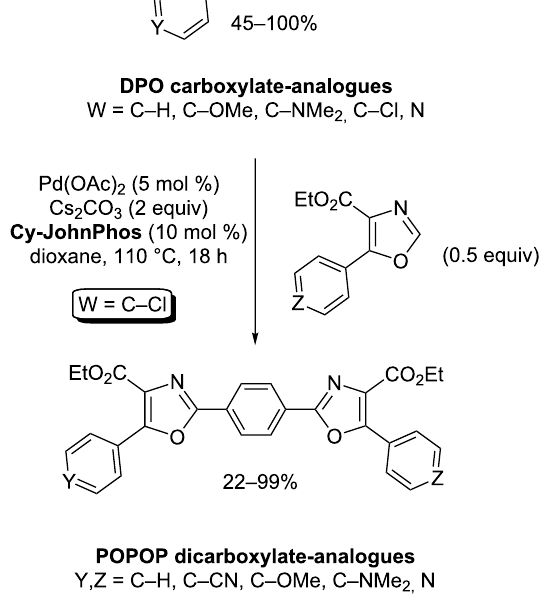
Scheme 11: Preparation of DPO- and POPOP-analogues [53].